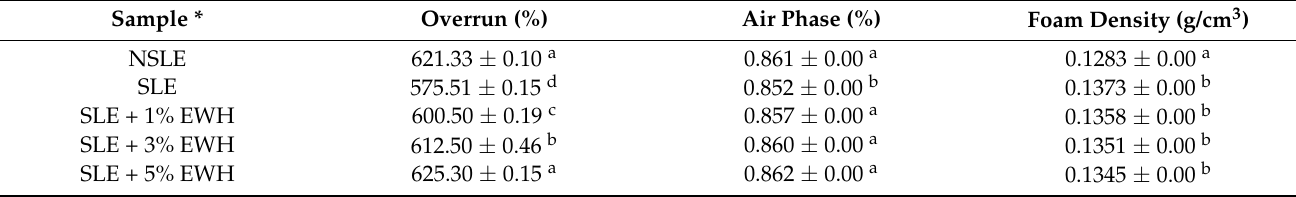
Table 2. Physical analysis of foam made by non-sterilized liquid egg white (NSLE), sterilized liquid egg white (SLE), and SLE supplemented with 1%, 3%, or 5% egg white hydrolysate (EWH). Sample